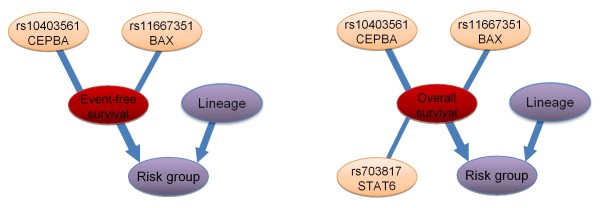
Subgraphs of the strongly relevant variables in event-free and overall survival. Left: The “averaged structure” of the subgraphs of the strongly relevant variables in event-free survival according to the BN-BMLA method. Right: The “averaged structure” of the subgraphs of the strongly relevant variables in overall survival according to the BN-BMLA method. The width of the edges is proportional to their a posteriori probability. Edges are shown only if their a posteriori probability exceed 0.5. The probability of the edges is computed by averaging over the Bayesian networks visited by the MCMC process. See Methods. Target variables are indicated with red color, phenotypic variables with purple color, and SNPs with orange color.